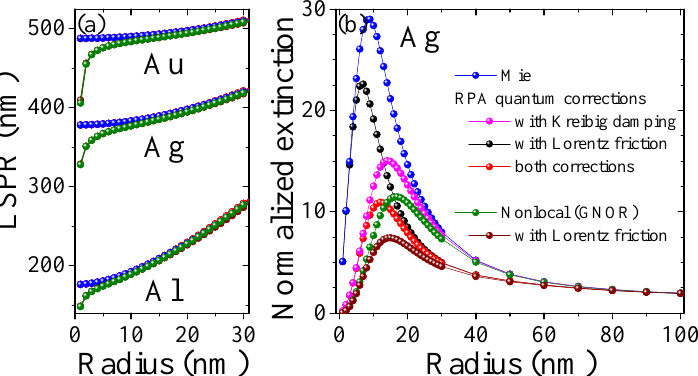
Figure 2. Impact of quantum corrections on single nanoparticles. ( a ) Spectral position of the localized surface plasmon resonance (LSPR) for gold, silver and aluminum; ( b ) Extinction cross section normalized to the surface of a hemisphere for silver evaluated at the respective LSPR wavelengths from ( a ).